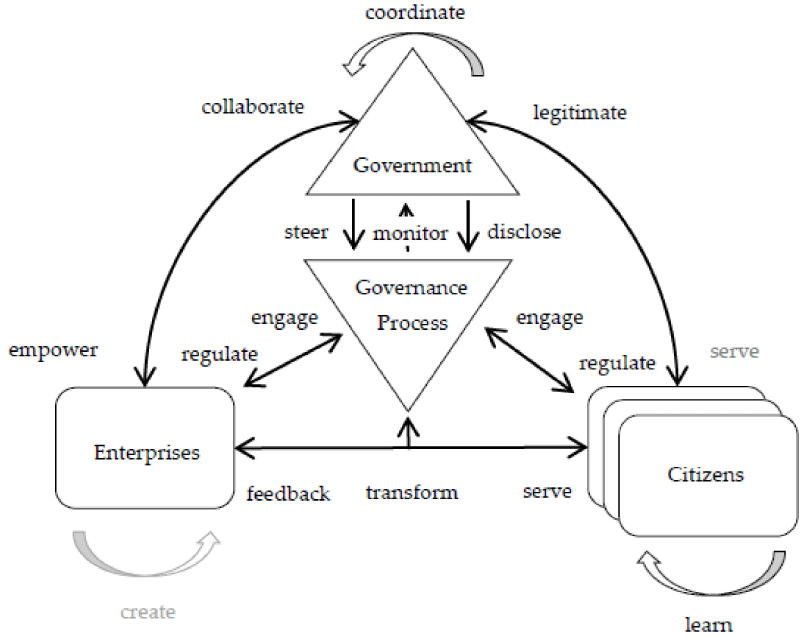
Figure 5. Framework instantiation, Guangdong e-governance project